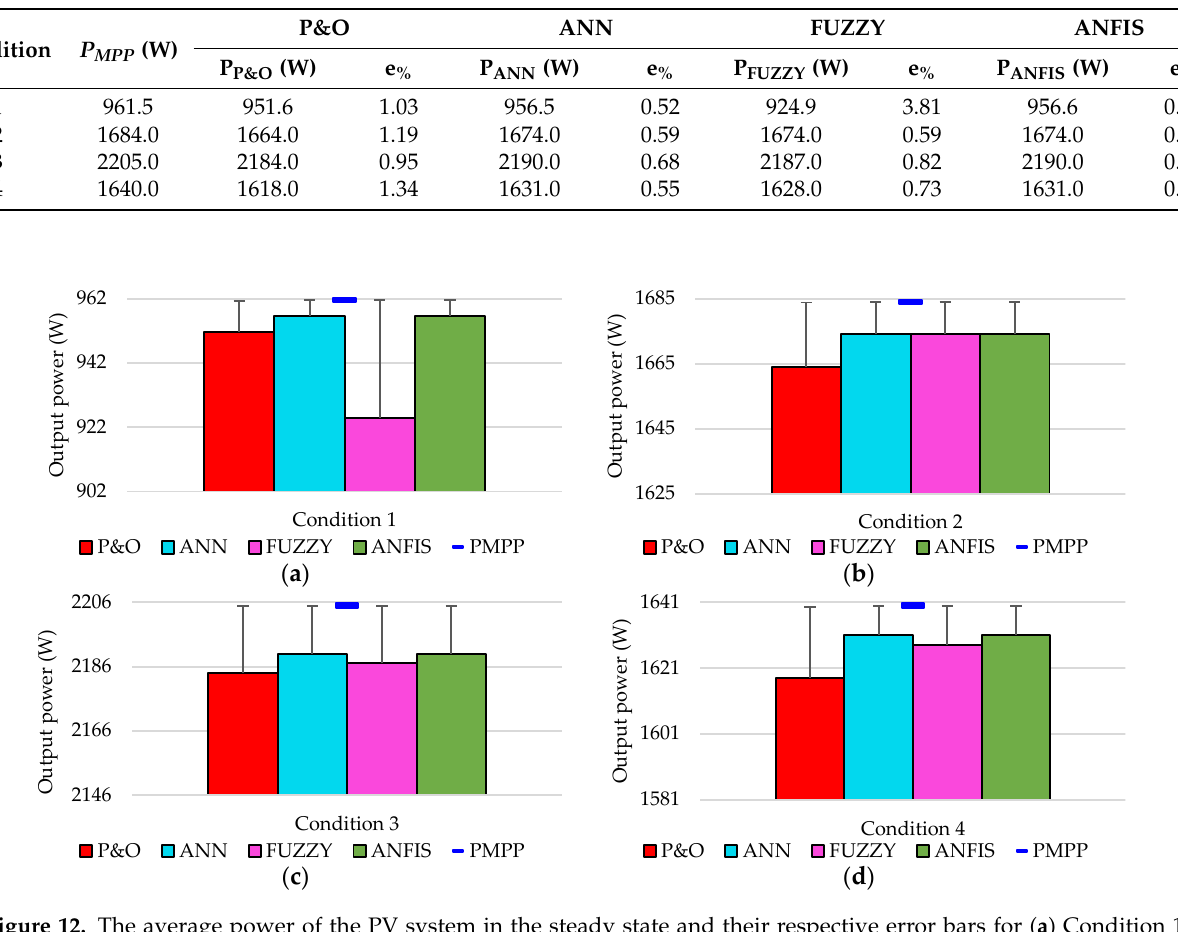
Table 10. The average power of the PV system in the steady state, and the respective relative percentage error.